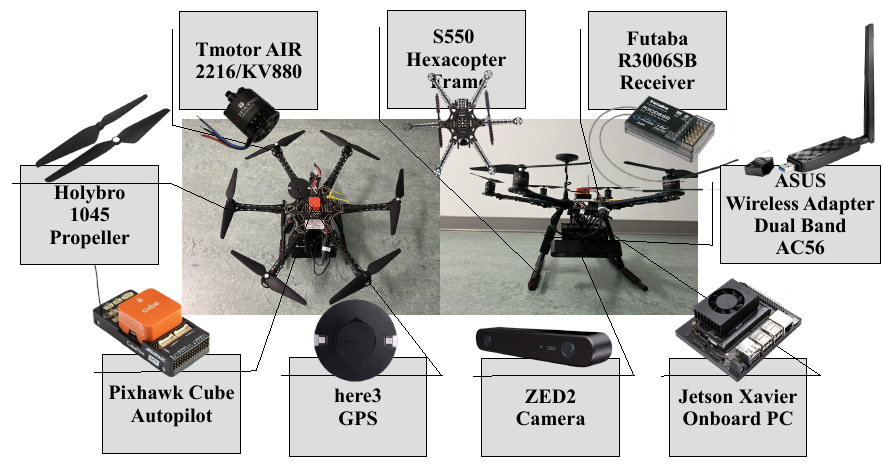
Figure 7. The drone properties utilized through the swarm